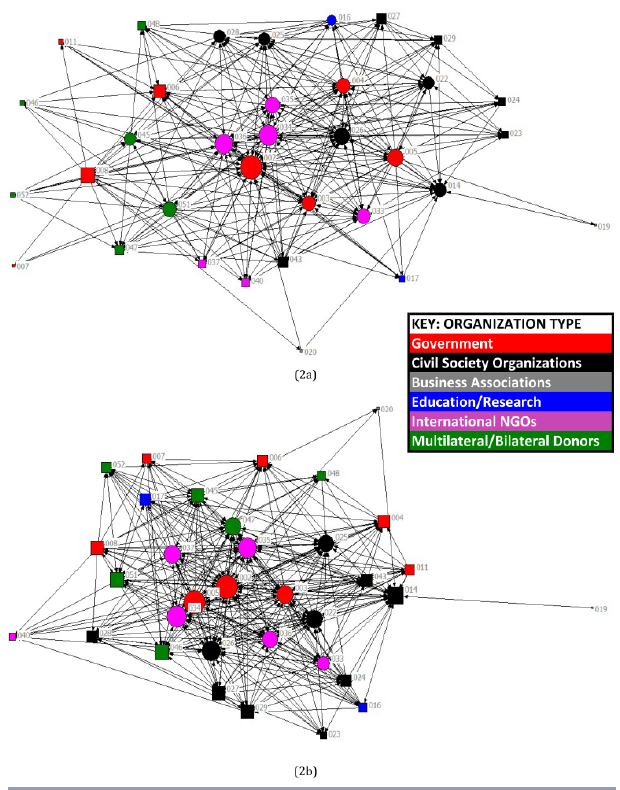
Fig. 2. Organizations in the REDD+ policy arena in Nepal that regularly discuss and exchange information (a) and collaborate (b) with each other on REDD+ issues. N = 34 organizations. The size of nodes indicates degree centrality, i.e., the number of incoming and outgoing ties. Circular nodes indicate actors in the core; square nodes indicate actors in the periphery. Node color denotes organization type, as indicated in the key. Numbers accompanying each node correspond to the organization identification numbers (Table